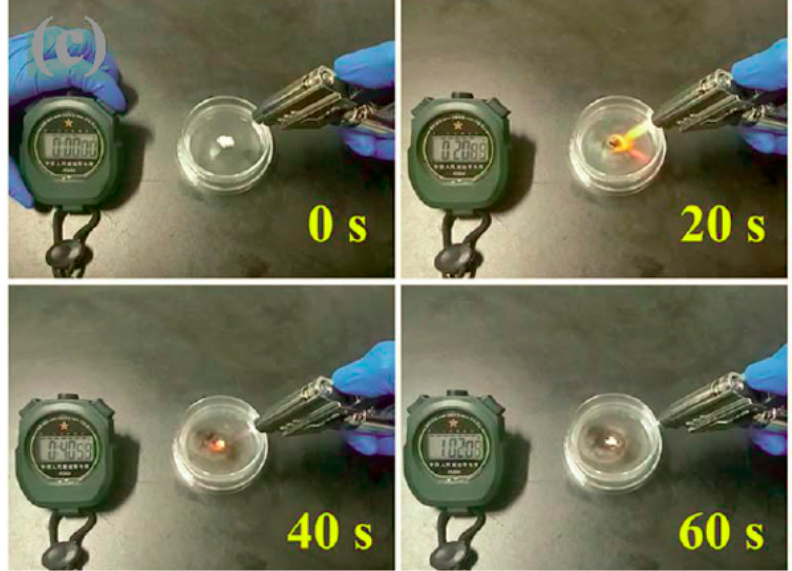
Figure 16. Flammability test of the ZIE using a flame gun [53]. Reproduced from Reference [35] with permission from the Royal Society of Chemistry.